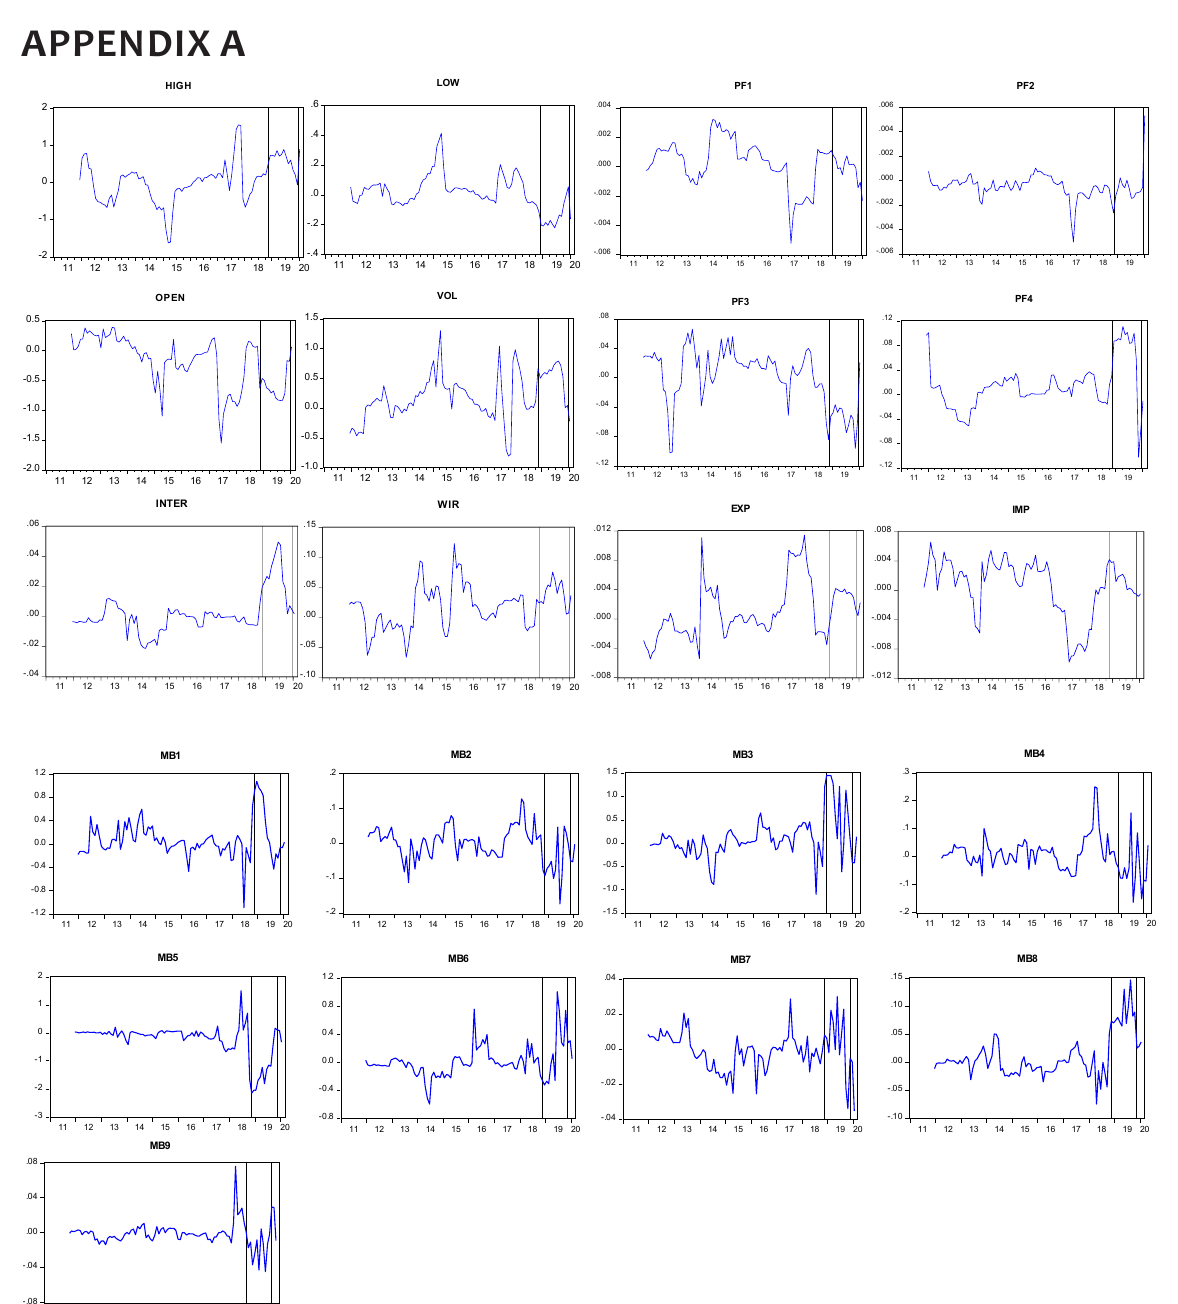
Note: Rolling regression estimates (with 12 months window size and one step ahead) after estimating Model 6. Shaded lines from left to right indicate the periods when the Jordanian tax law has been amended (November 2018) and the starting date Figure A1. Rolling regression estimates from Model